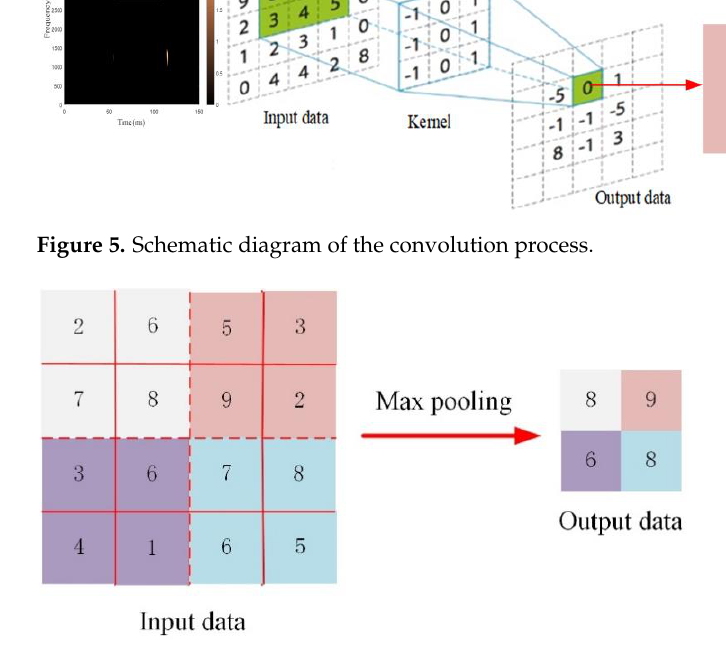
Figure 6. Schematic diagram of the max pooling process.